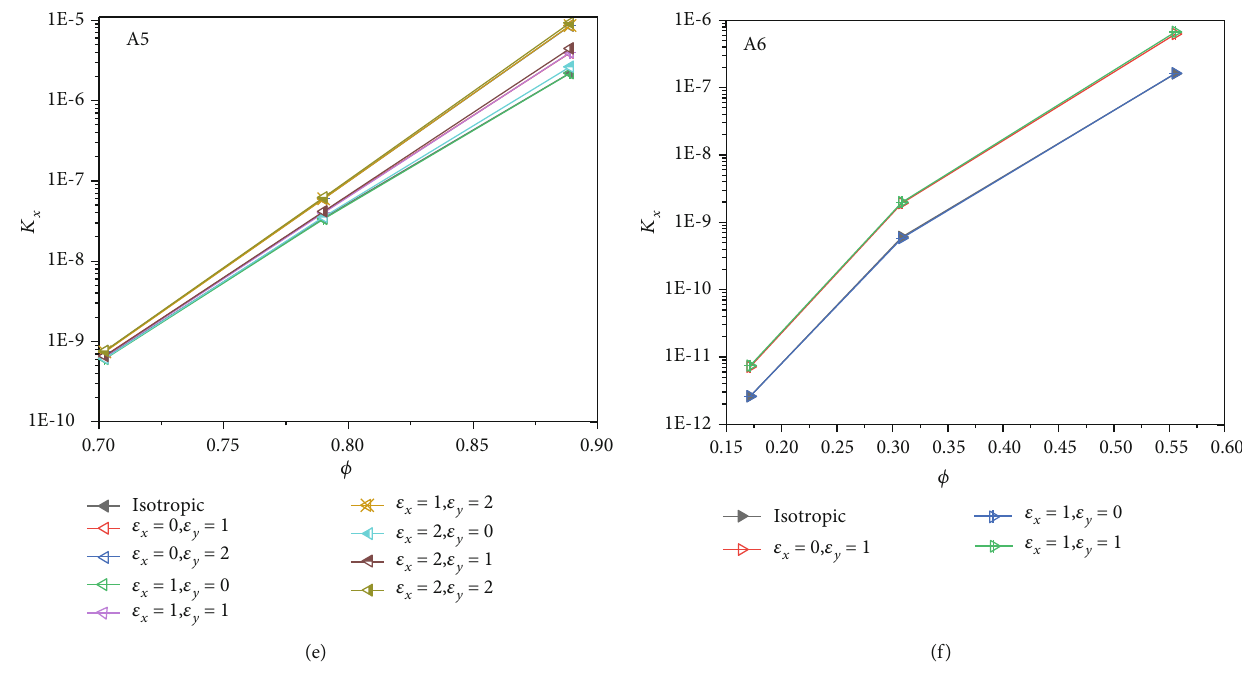
Figure 6: The permeability of anisotropic Sierpinski carpet models: (a) A1 ( D ( D = 1 : 723 ), (e) A5 ( D f